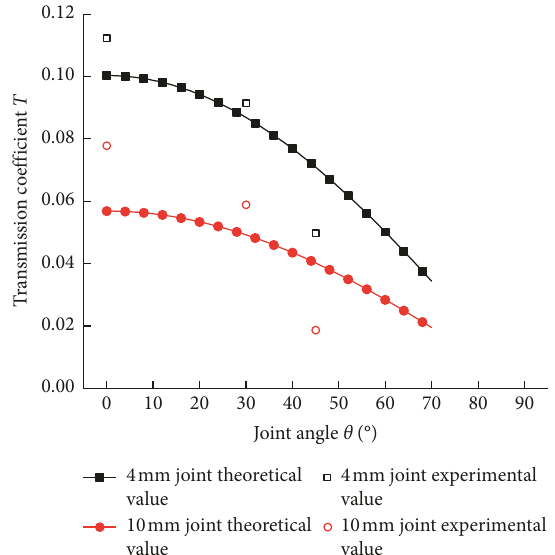
Figure 11: Comparison of transmission energy coefficients between theoretical and experimental